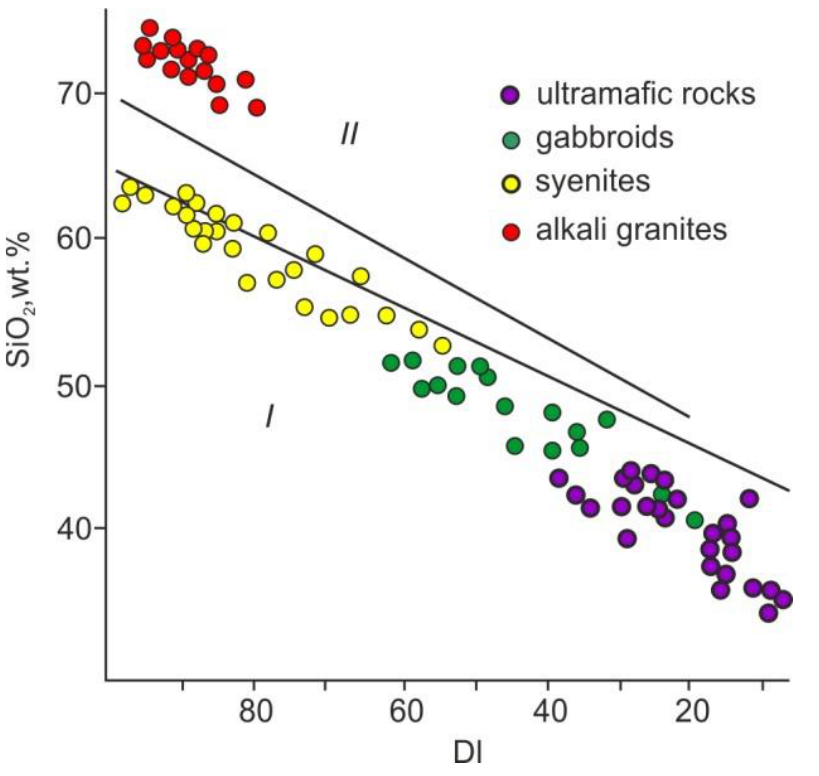
Figure 22. SiO 2 vs. DI diagram for igneous rocks of the Tommot and Somnitelnyi massifs. Fields in the diagram after [53]: I — derivatives of mantle melts, II — derivatives of crustal melts .